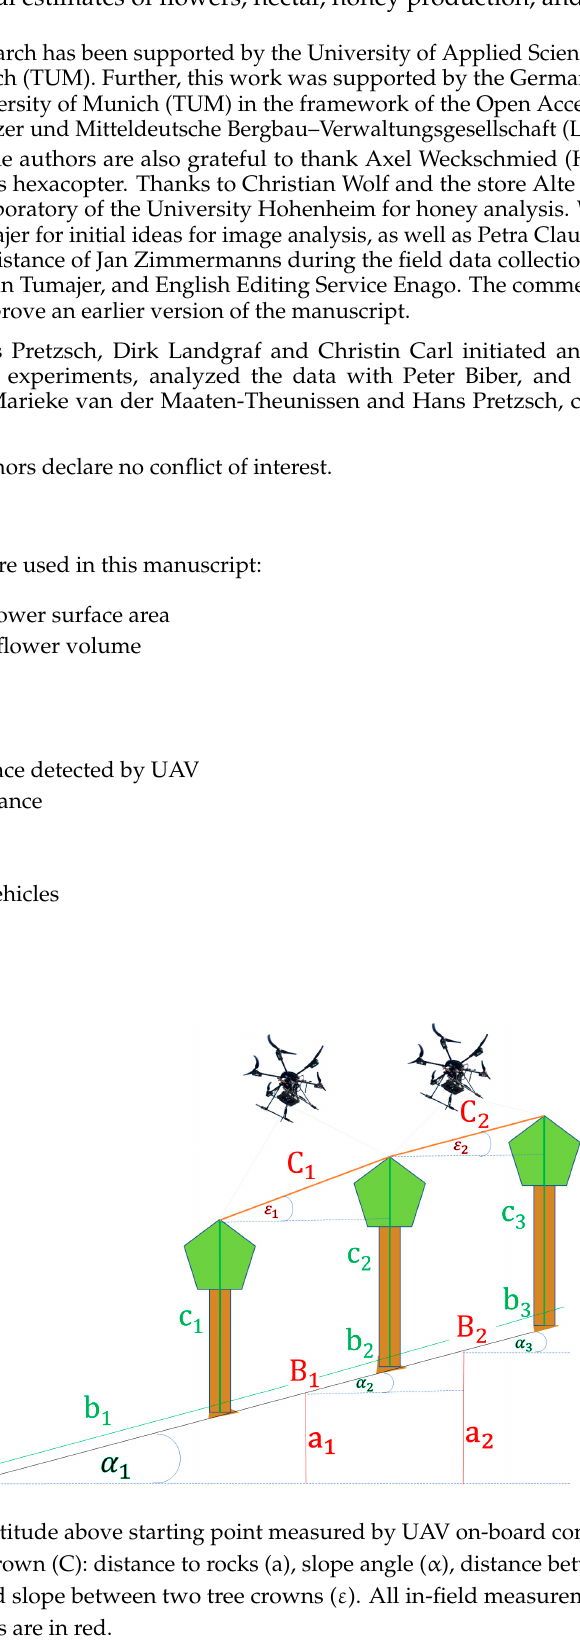
Therefore, a is calculated by using the slope angle ( α ) and distance between the lines (b) for each line analyzed (Figure A1):